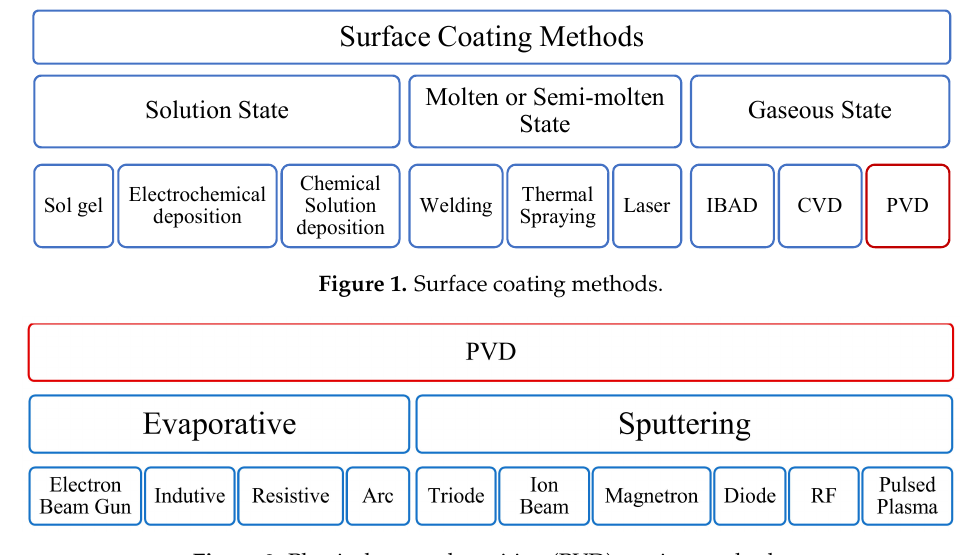
Figure 2. Physical vapor deposition (PVD) coating